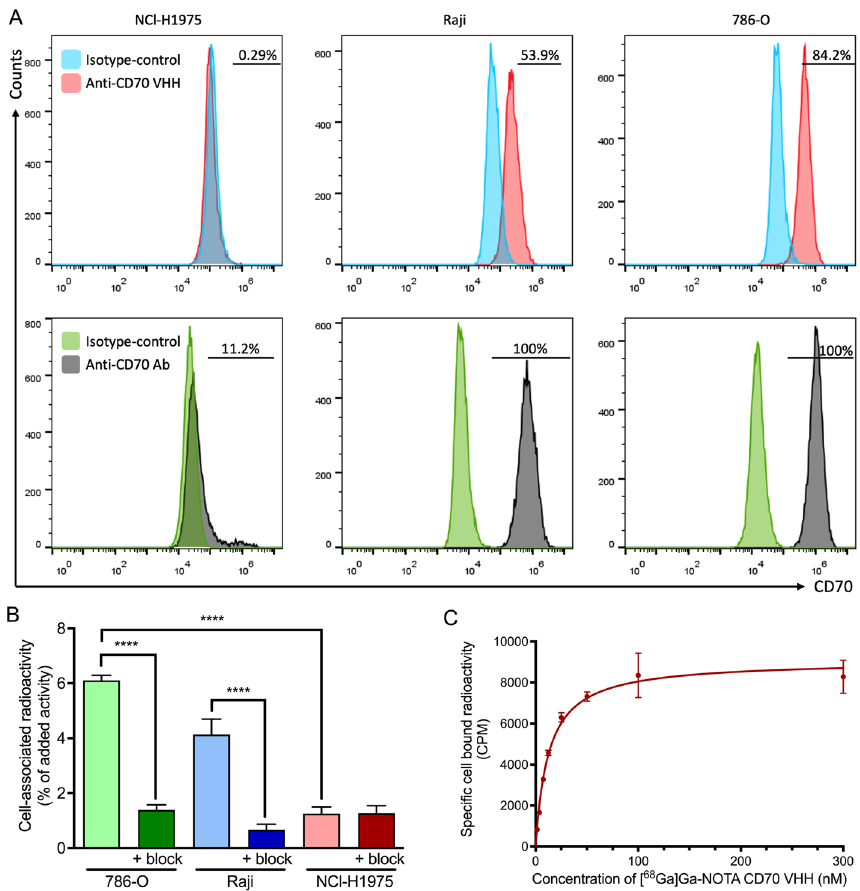
Fig. 1 In vitro characterization of [ 68 Ga]Ga-NOTA-anti-CD70 VHH. A Analysis of CD70 protein expression measured by flow cytometry using in the upper trace anti-CD70 VHH-Hilyte Fluor 488 (107B8) or control VHH-Hilyte Fluor 488 and in the lower trace PE mouse anti-human CD70 or PE mouse IgG3 isotype control. B Relative amount of cell associated activity of [ 68 Ga]Ga-NOTA-anti-CD70 VHH (5 nM, 0.04 µg) on CD70 high and CD70 low cells (1 10 6 ), or in the presence of excess unlabeled VHH (50 µg, block). (C) Specific binding of × [ 68 Ga]Ga-NOTA-anti-CD70 VHH on Raji cells (5 10 5 ). (**** p < ×